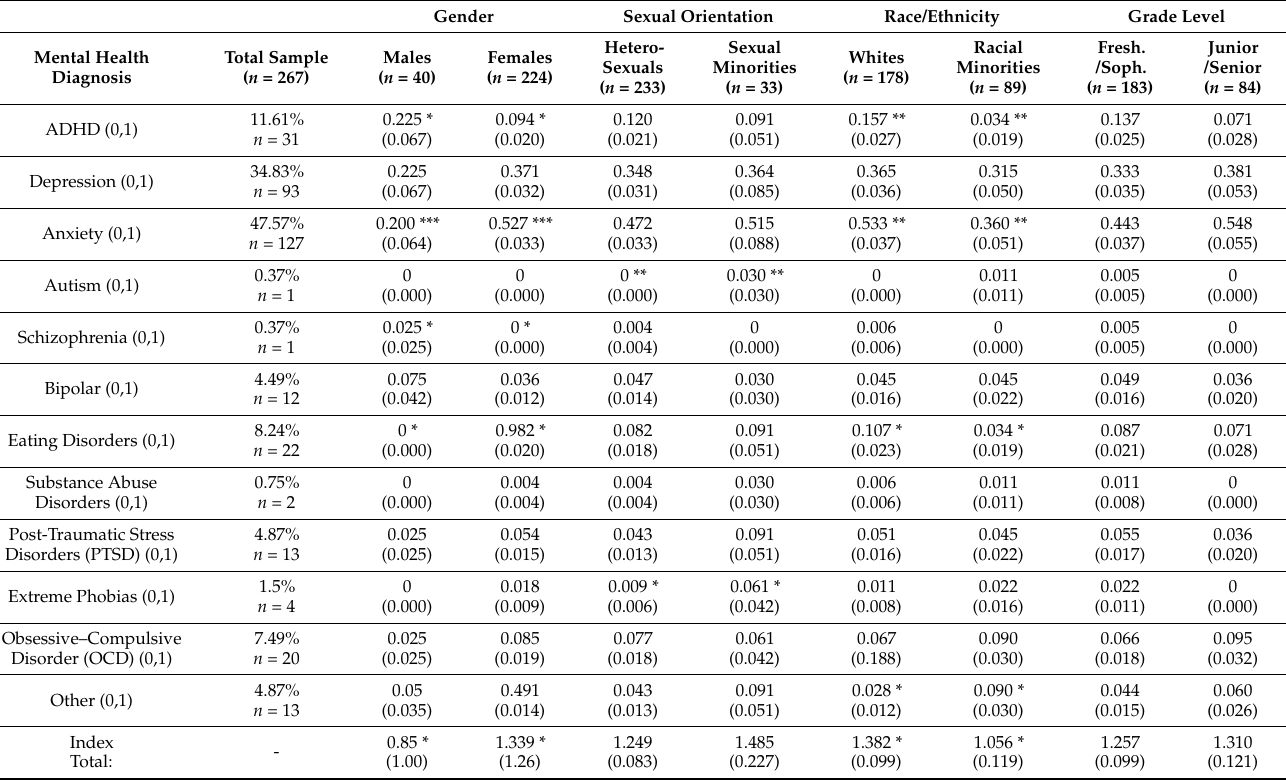
Table 1. Initial Analyses of Mental Health Conditions in College by Social Location. Gender Sexual Orientation Race/Ethnicity Grade